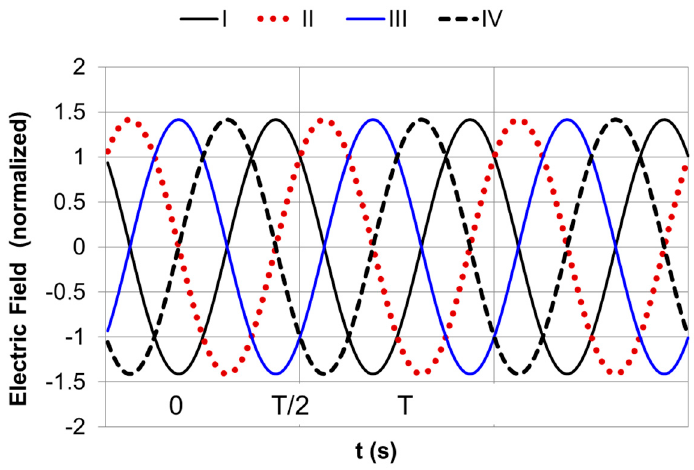
Figure 7. Electric fields in the four regions of the octagonal piezoelectric plate when the magnitudes A, B and thickness d are normalized to 1. Frequencies ( w 1 and w 2 ) for both signals are assumed to be equal and T is the period (phase shift ( ϕ ) is 90 degrees).